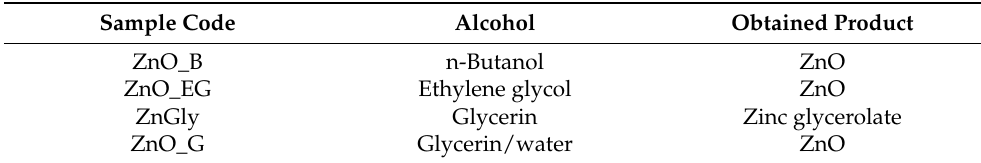
Table 5. Sample labels for each solvent